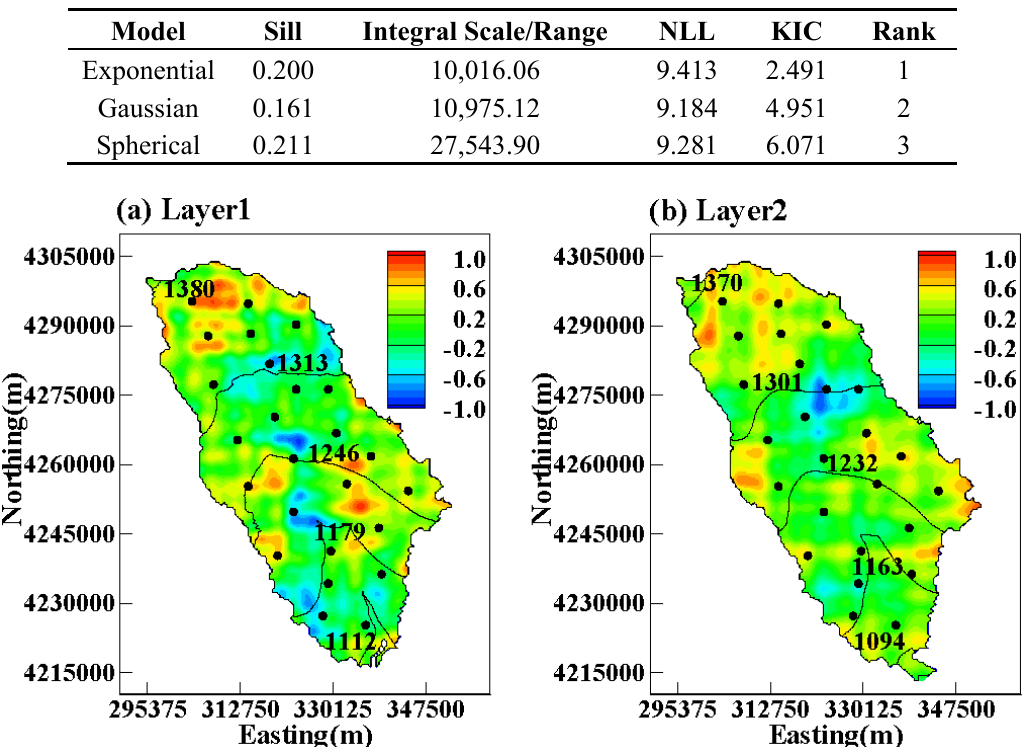
Table 2. The parameter, NLL and KIC values, and model rank for the upper layer.